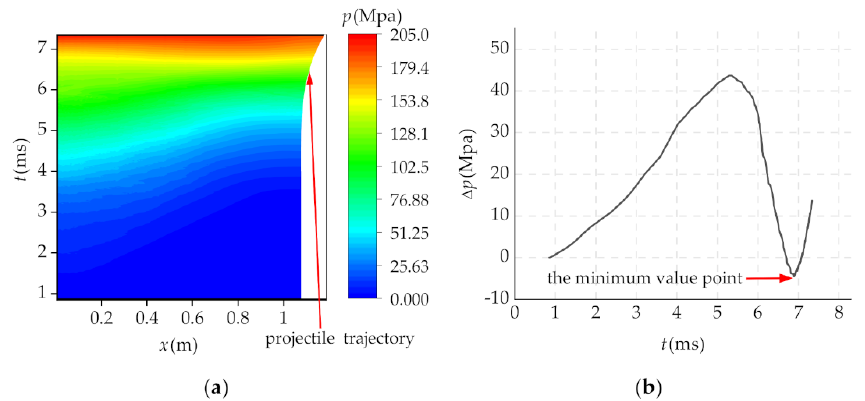
Figure 9. ( a ) Displacement–time–pressure data of the propellant gas; ( b ) time–pressure wave data of the propellant gas.